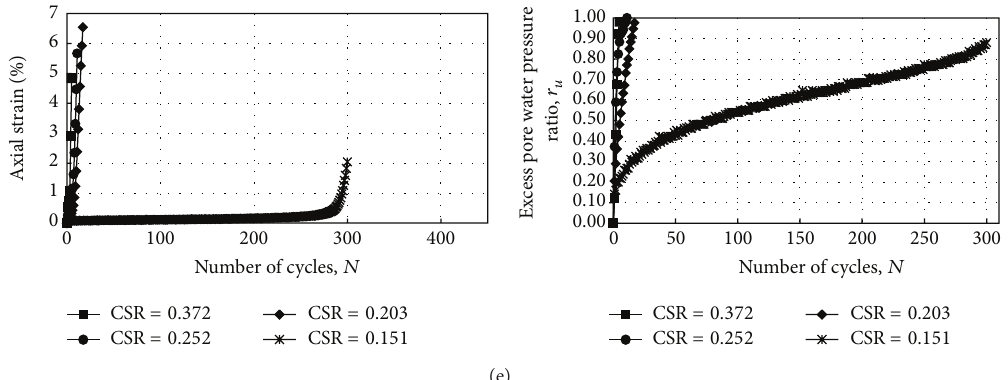
Figure 5: The excess pore water pressure-number of cycles relationship and the axial strain-number of cycles relationship for different grain size distributions (a) 54% fine 4% clay. (b) 51% fine 6% clay. (c) 71% fine 9% clay. (d) 67% fine 10% clay. (e) 73% fine 12% clay.